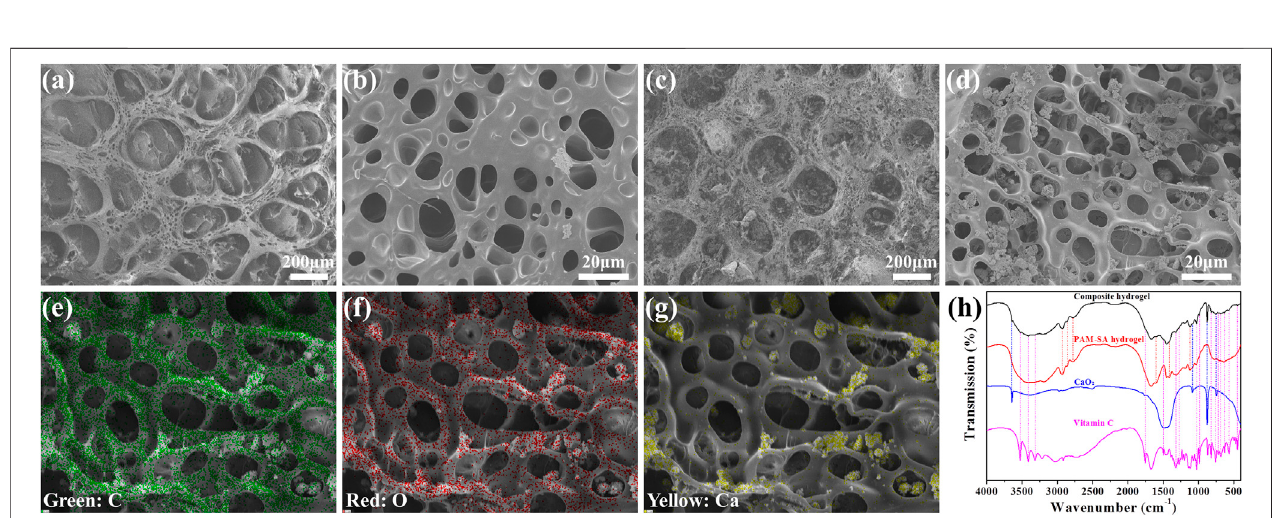
FIGURE 1 | (A) SEM images of CaO 2 NPs. (B) XRD pattern of CaO 2 NPs. (C) TGA curve of CaO 2 NPs.